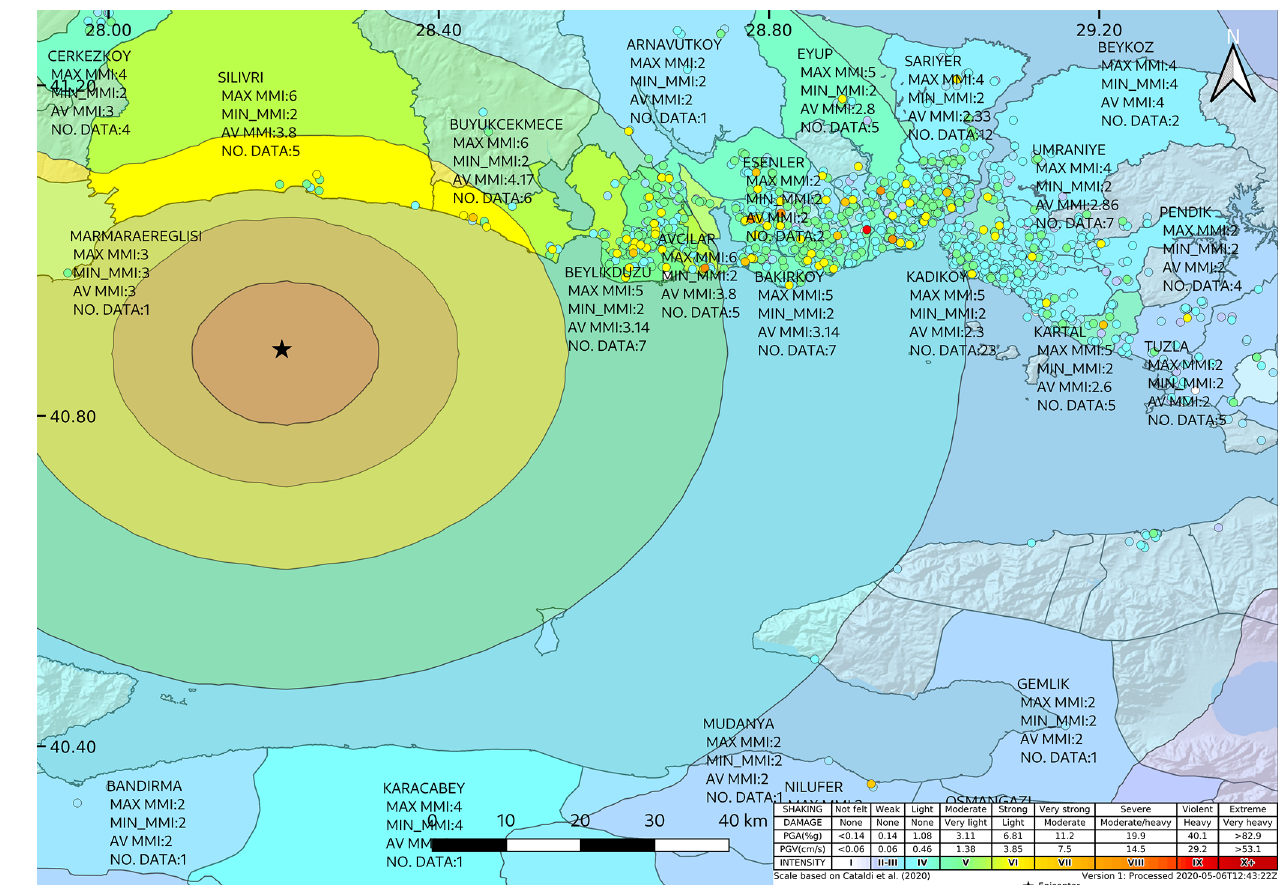
Figure 4. Intensity map of the 26 September 2019 Istanbul earthquake with labeled entries. Entries are plotted to district level polygons. Felt reports of the earthquake submitted to EMSC are at the top of the labeled entries (created using